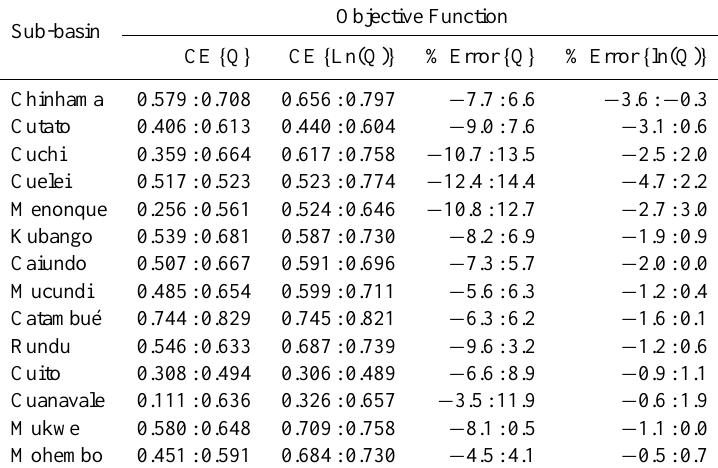
Table 1. Calibration results including uncertainty in some of the main water balance parameters, the two values represent the highest and lowest values for each objective function amongst all 1000 simulation ensembles.